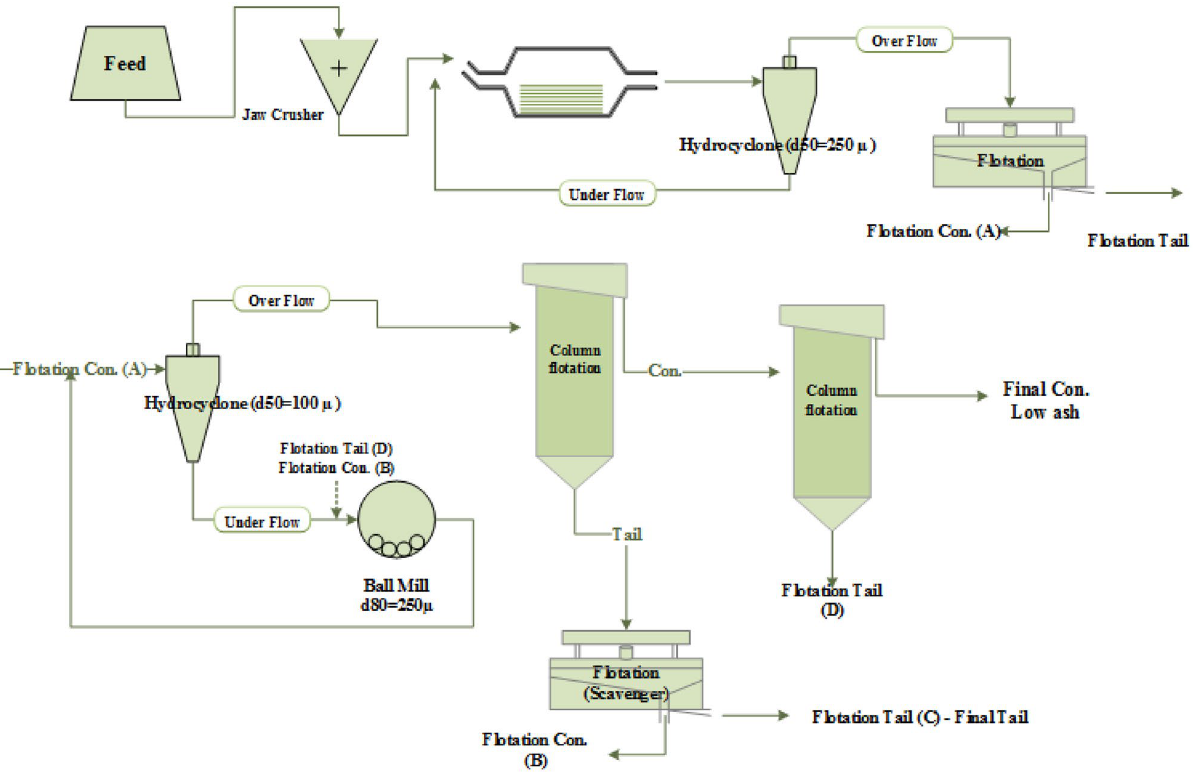
Figure 9. Gilsonite flotation circuit flowsheet for the production of ultra-low ash